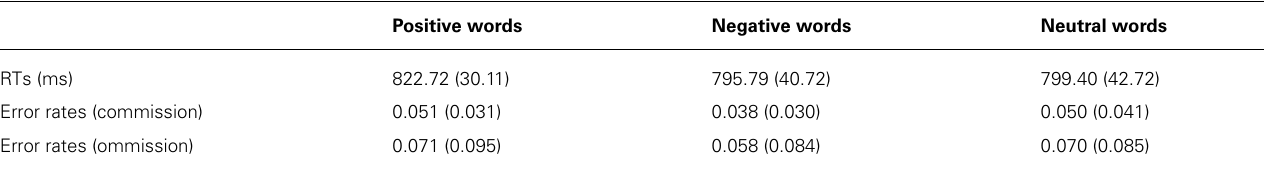
Table 2 | Means and SD (in parenthesis) of reaction times (RTs) and errors rates (commission/omission) to each word category (positive, negative, and